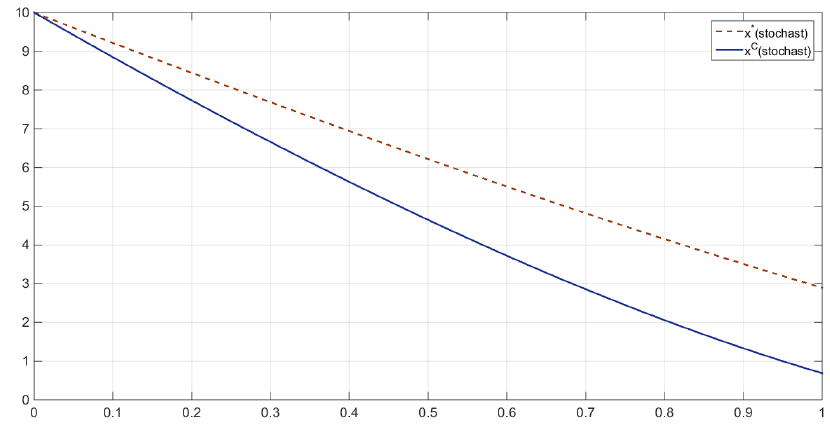
Figure 4. Comparison between Nash equilibrium and cooperative equilibrium for x ( t )